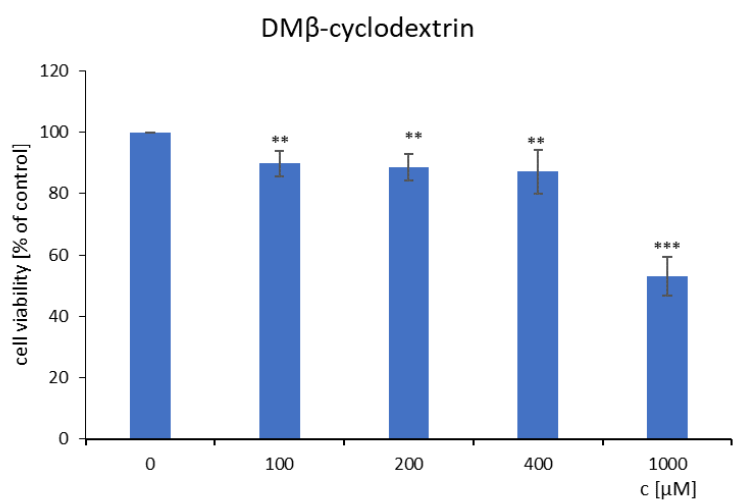
Figure 11. The Chinese hamster cells (B14) viability incubated with heptakis (2,6-di-O-methyl)- β -cyclodextrin after 24 h. Error bars represent S.D. ** p < 0.01 *** p < 0.001 confronted with the untreated cells.